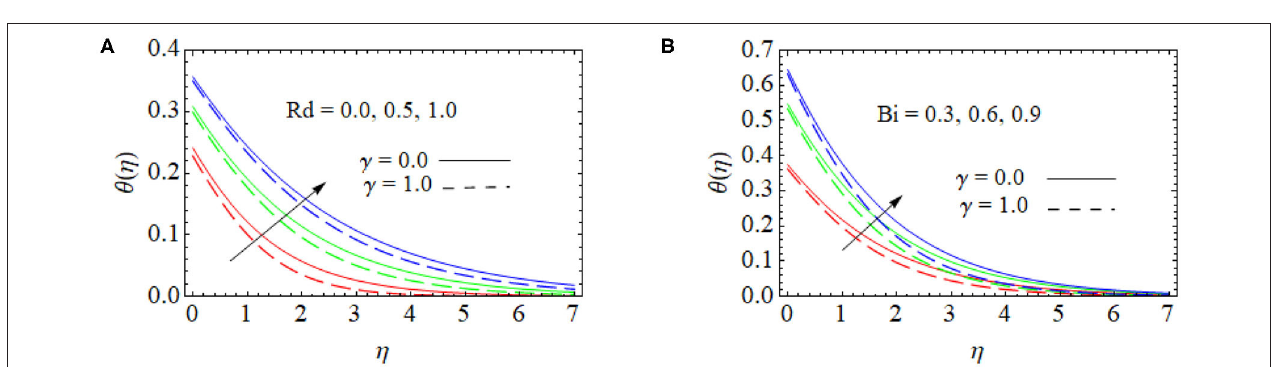
FIGURE 4 | (A,B) Impact of Rd and Bi on temperature profile θ ( η ).